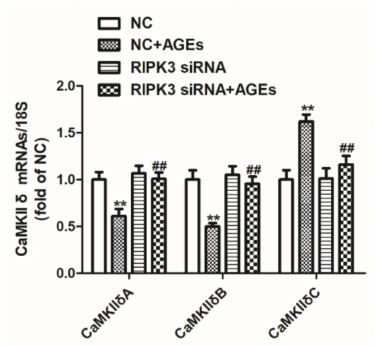
Figure 8. Down regulation of RIPK3 ameliorated the alternative splicing disorder of CaMKII δ in cardiomyocytes. Cardiomyocytes were transfected with RIPK3 siRNA for 4 h followed by 200 µ g/mL AGEs stimulation for 24 h. The mRNA expression of CaMKII δ A, CaMKII δ B, and CaMKII δ C was detected by quantitative real-time PCR in cardiomyocytes. 18S was used as a loading control. Plots represent the mean ± SEM; n = 6. Statistical significance: ** p < 0.01 compared with NC; ## p < 0.01 compared with NC+AGEs.